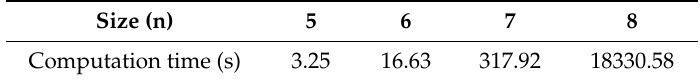
Table 3. CPU times of RO approach using scenario concept with IBM ILOG CPLEX Optimization software